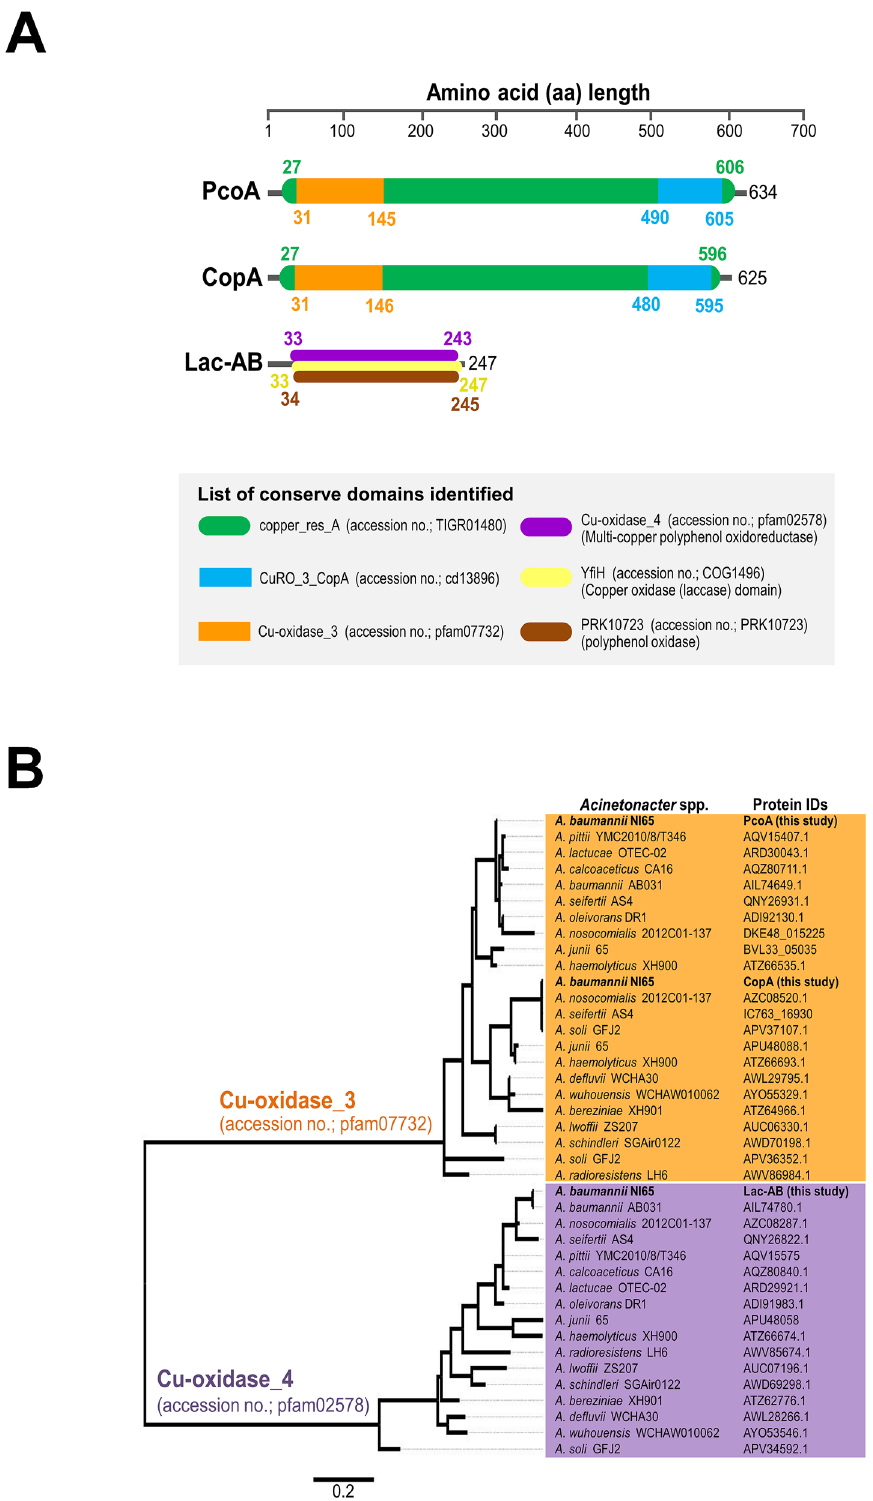
Figure 3. Conserved domains and phylogenetic tree analysis of three laccase proteins identified in the genome of NI-65. ( A ) The domain organization of three laccase proteins are PcoA, CopA, and Lac-AB. Each domain represented Cu-oxidase_3; Multicopper oxidase, CuRO_3_CopA; copper_res_A, the third cupredoxin domain of CopA copper resistance protein family; copper-resistance protein, CopA family, Cu-oxidase_4; Multicopper polyphenol oxidoreductase laccase, YfiH, copper oxidase domain, and polyphenol oxidase domain. ( B ) Phylogeny inferred from amino acid sequences of laccase coding-proteins containing Cu-oxidase_3 and Cu-oxidase_4 that were detected in the genomes of Acinetobacter spp. deposited at the NCBI